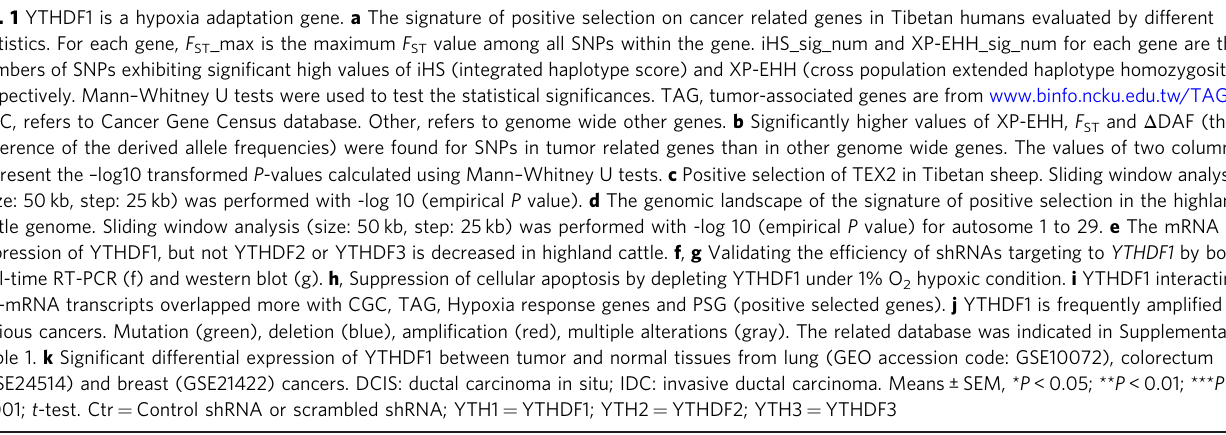
Fig. 1 YTHDF1 is a hypoxia adaptation gene. a The signature of positive selection on cancer related genes in Tibetan humans evaluated by different statistics. For each gene, F ST _max is the maximum F ST value among all SNPs within the gene. iHS_sig_num and XP-EHH_sig_num for each gene are the numbers of SNPs exhibiting signi fi cant high values of iHS (integrated haplotype score) and XP-EHH (cross population extended haplotype homozygosity) respectively. Mann – Whitney U tests were used to test the statistical signi fi cances. TAG, tumor-associated genes are from www.binfo.ncku.edu.tw/TAG/; CGC, refers to Cancer Gene Census database. Other, refers to genome wide other genes. b Signi fi cantly higher values of XP-EHH, F ST and Δ DAF (the difference of the derived allele frequencies) were found for SNPs in tumor related genes than in other genome wide genes. The values of two columns represent the – log10 transformed P -values calculated using Mann – Whitney U tests. c Positive selection of TEX2 in Tibetan sheep. Sliding window analysis (size: 50 kb, step: 25 kb) was performed with -log 10 (empirical P value). d The genomic landscape of the signature of positive selection in the highland cattle genome. Sliding window analysis (size: 50 kb, step: 25 kb) was performed with -log 10 (empirical P value) for autosome 1 to 29. e The mRNA expression of YTHDF1, but not YTHDF2 or YTHDF3 is decreased in highland cattle. f , g Validating the ef fi ciency of shRNAs targeting to YTHDF1 by both real-time RT-PCR (f) and western blot (g). h , Suppression of cellular apoptosis by depleting YTHDF1 under 1% O 2 hypoxic condition. i YTHDF1 interacting m 6 -mRNA transcripts overlapped more with CGC, TAG, Hypoxia response genes and PSG (positive selected genes). j YTHDF1 is frequently ampli fi ed in various cancers. Mutation (green), deletion (blue), ampli fi cation (red), multiple alterations (gray). The related database was indicated in Supplementary Table 1. k Signi fi cant differential expression of YTHDF1 between tumor and normal tissues from lung (GEO accession code: GSE10072), colorectum (GSE24514) and breast (GSE21422) cancers. DCIS: ductal carcinoma in situ; IDC: invasive ductal carcinoma. Means ± SEM, * P < 0.05; ** P < 0.01; *** P